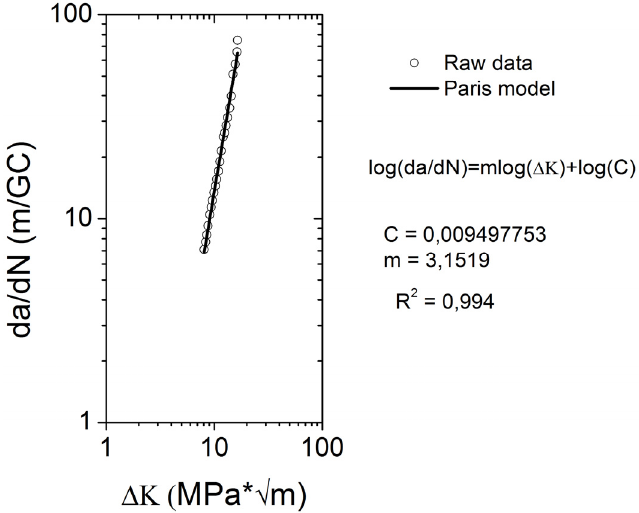
Figure 13: Crack propagation curves and Paris